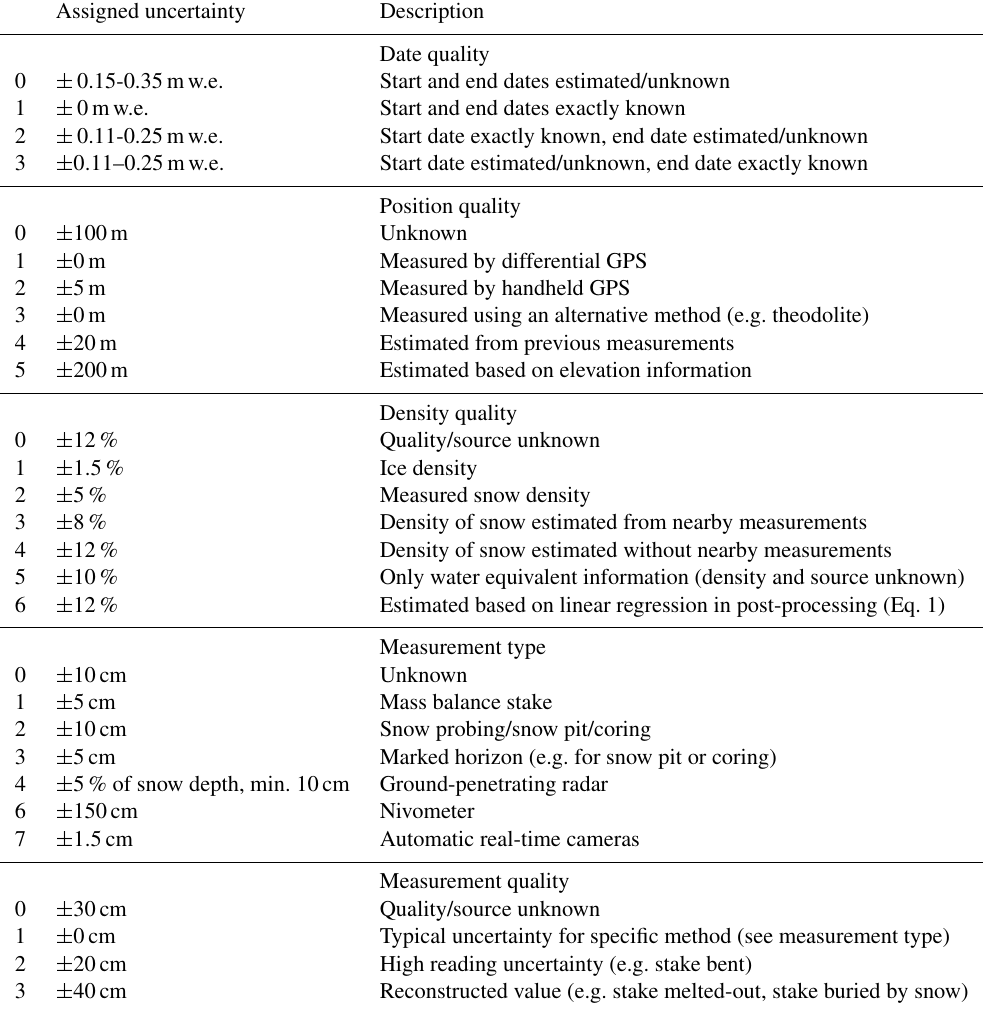
Table 1. Attributes of the metadata. All elements of the five attributes are described including typical uncertainties. Note that the uncertainty for unknown observation dates (14d) has been translated into a corresponding mass balance error depending on elevation. See Sect. 3.3 for details on the procedures to assign the